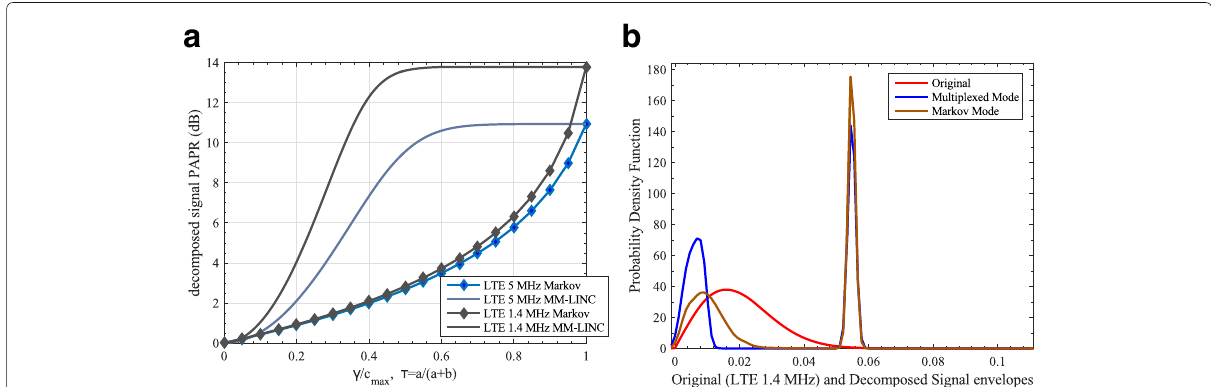
Fig. 3 PAPR and statistics parameters. a Input signal PAPR in terms of the policy parameters from closed-form expressions. b Example of pdfs for specific policy parameters